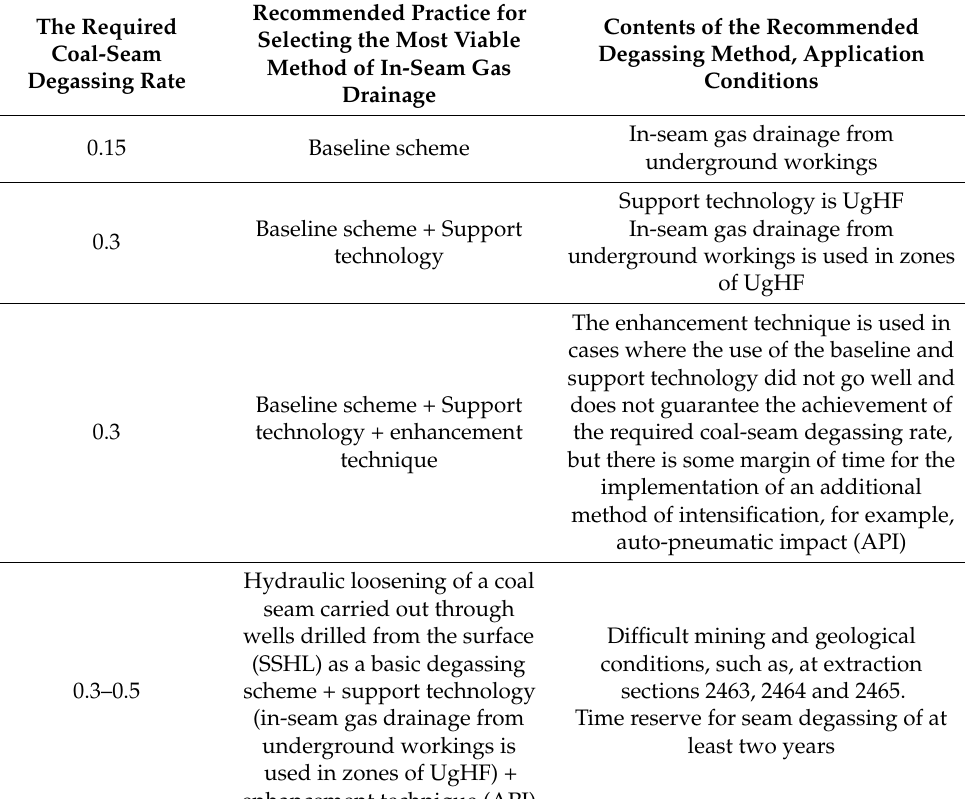
Table 2. Recommended practice for selecting the most viable method of in-seam gas drainage for high-production mining panels (Phase